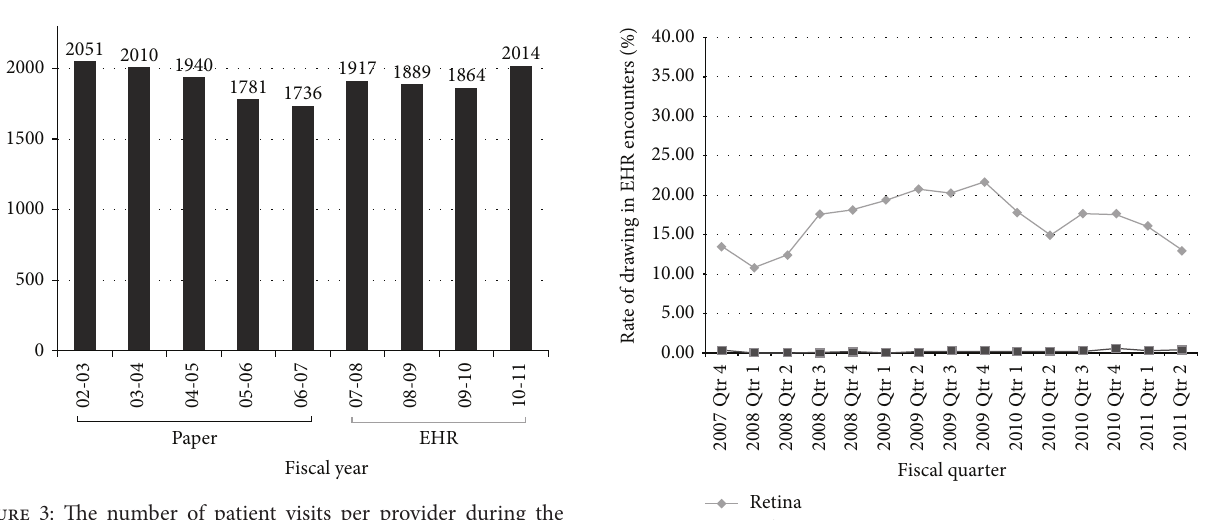
Figure 3: The number of patient visits per provider during the period of paper and of EHR documentation.